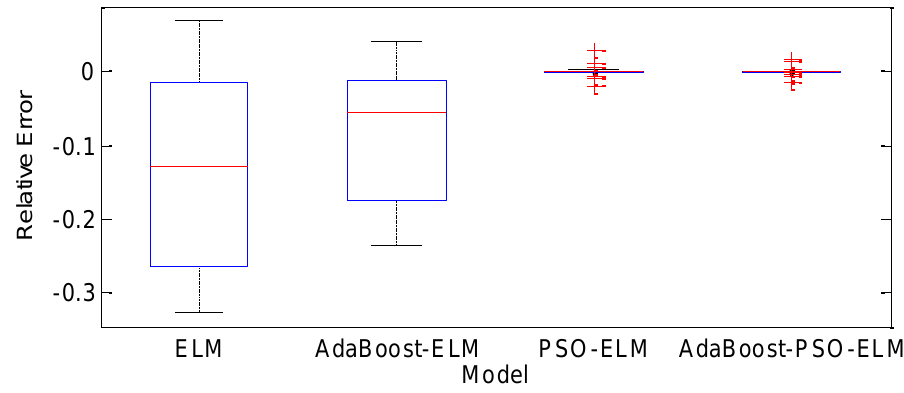
Figure 11. The boxplot of relative errors for different models.